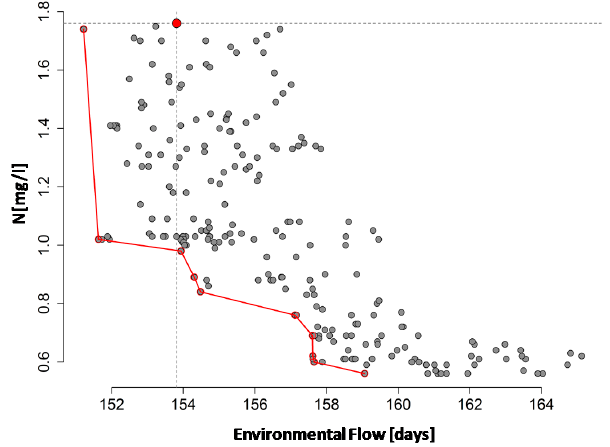
Figure 7. Results of the optimization run for the N and environmental flow criteria within the agriculture related measures group in the Danube region. Strategies that cross the red line (S1 to S8 in Table 4) are those that define the Pareto frontier (namely those solutions that are efficient according to the considered objectives). The red point corresponds to the baseline 2030 strategy.